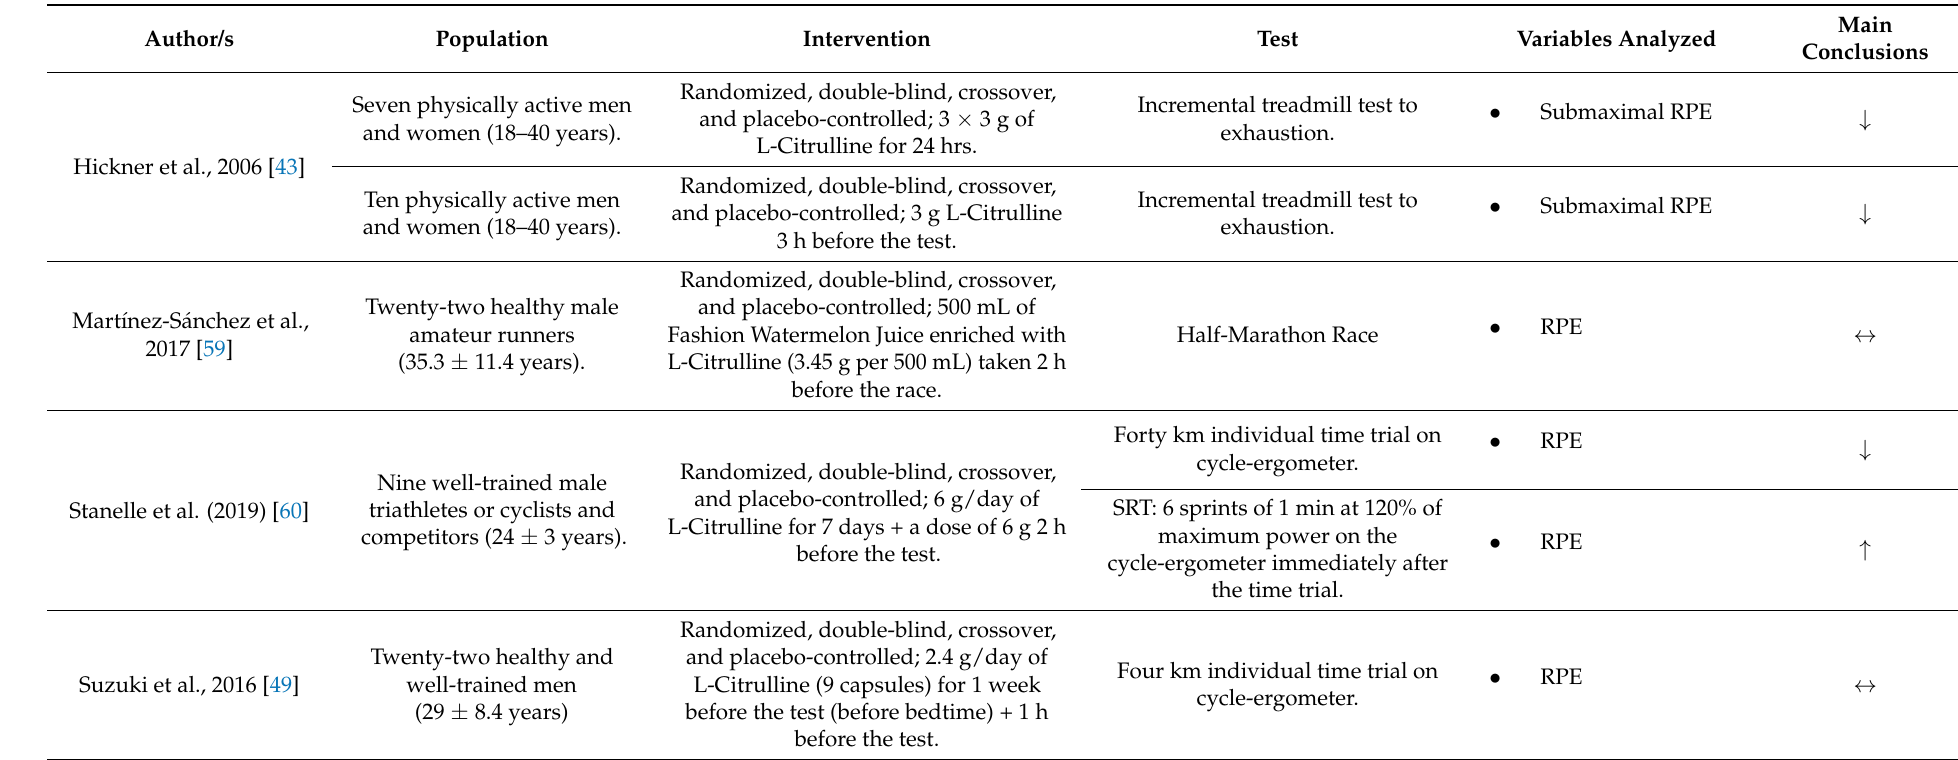
Table 3. Summary of studies included in the systematic review and meta-analysis investigating the effect of Cit on the rate of perceived exertion